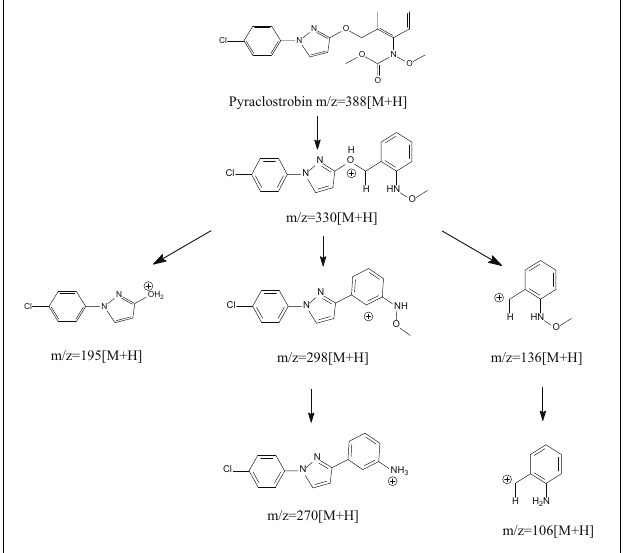
FIGURE 8 | Proposed metabolic mechanisms of pyraclostrobin in microorganisms (based on Chen et al., 2018).